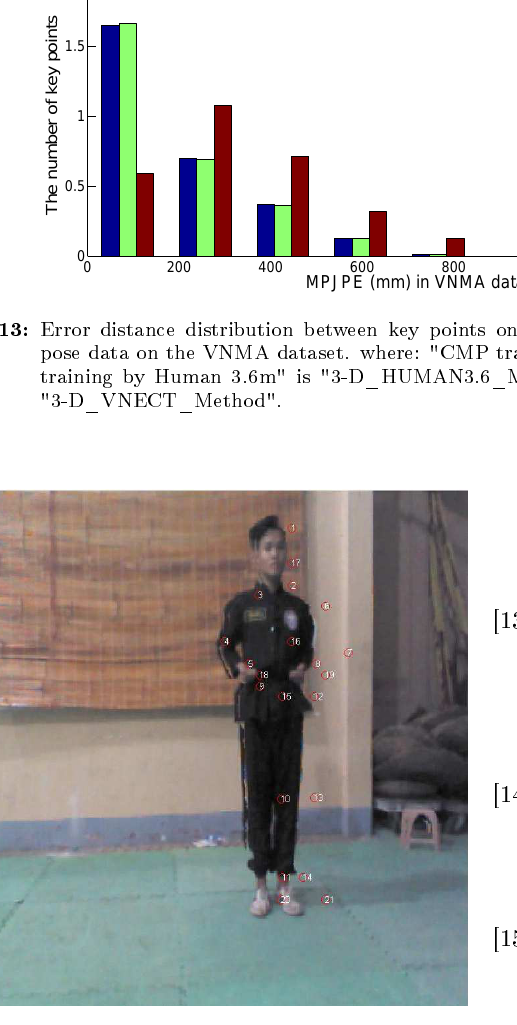
Fig. 14: The result of 2-D human pose estimation based on the method of Mehta et al. [36], 21 key points are